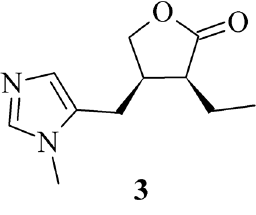
Figure 2 - Pilocarpine ( 3 ), imidazole alkaloid active ingredient of Salagen ®